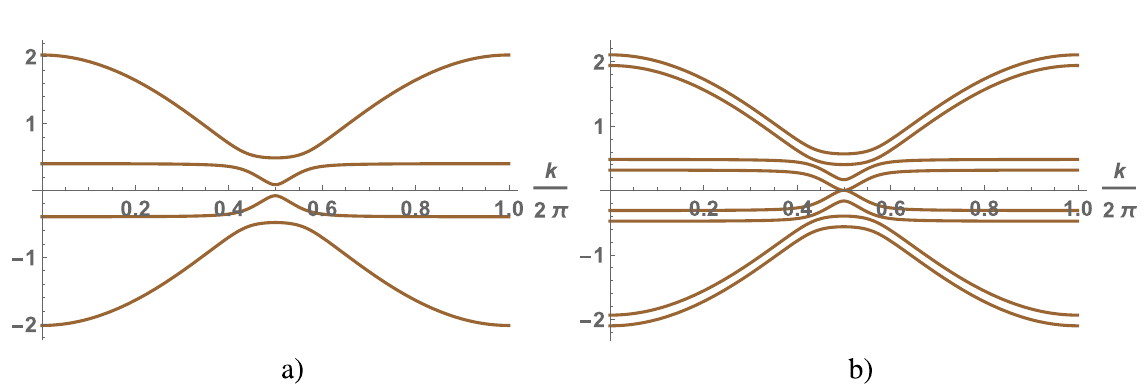
Figure 3. (Color online) A spectrum of the symmetric Anderson chain as a function of the wave vector calculated under the condition v < 2 √ 2 (cid:31) for v ( b